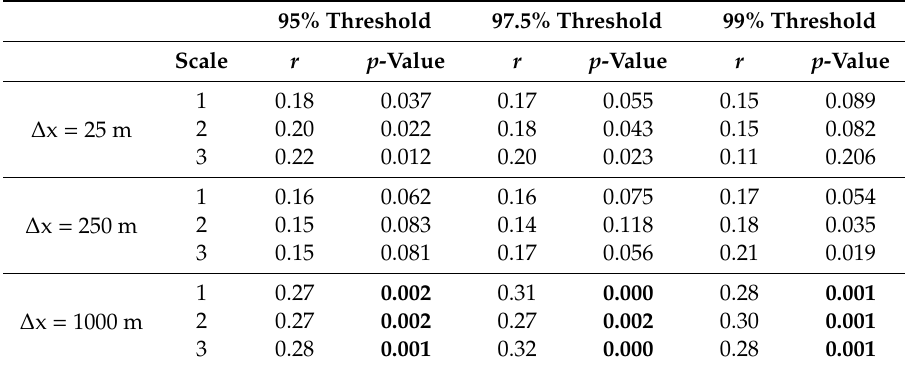
Table 3. Spearman rank correlation r and its p -value parameter ∇ 2 z related to the Laplacian of terrain height z and the wavelet variance of the inter-extreme time series of the wind extremes for di ff erent thresholds. The results below the significance level of 0.01 are in